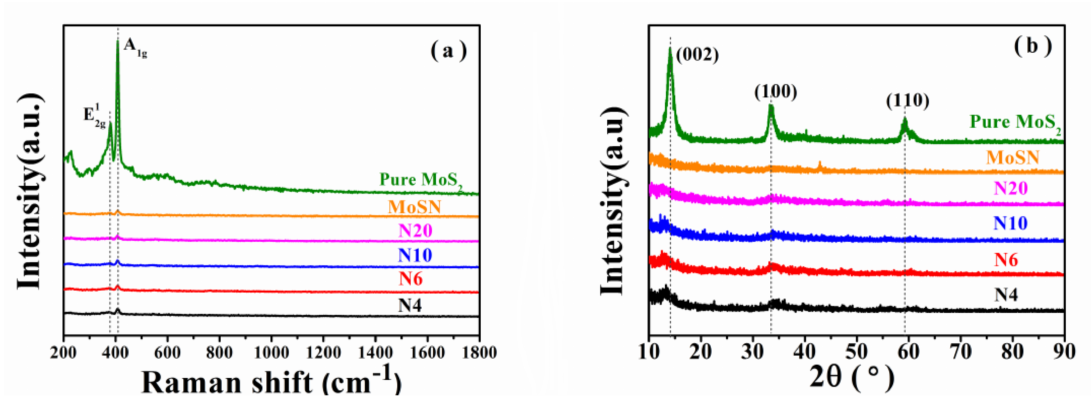
Figure 3. The structure characterization and XRD patterns of pure MoS 2 film, MoSN monolayer and MoSN/MoS 2 multilayer films deposited with different nitrogen flow rates. ( a ) Raman spectra and ( b ) glancing angle XRD patterns of studied films.